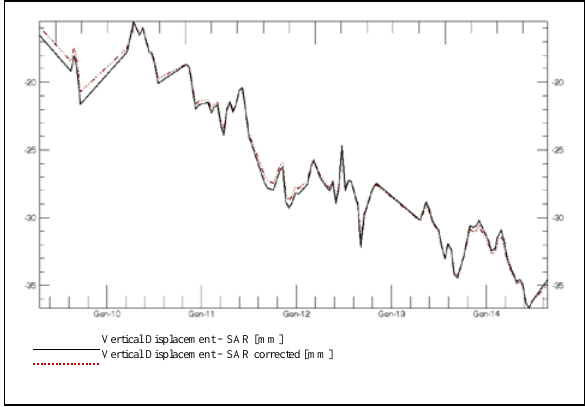
Figure 14. SAR vertical component corrected with a regional component of land